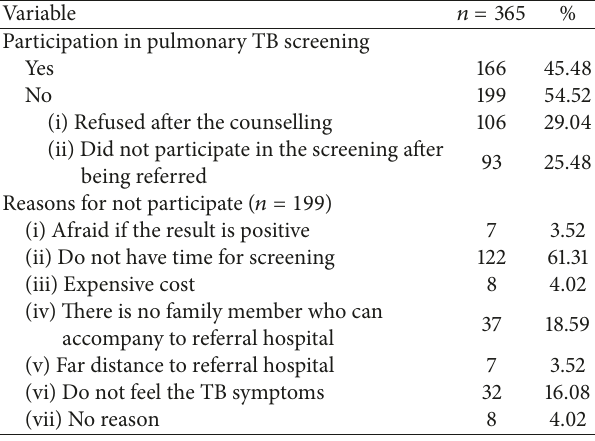
Table 2: The overview of DM patient’s participation in pulmonary TB screening Denpasar, January–March